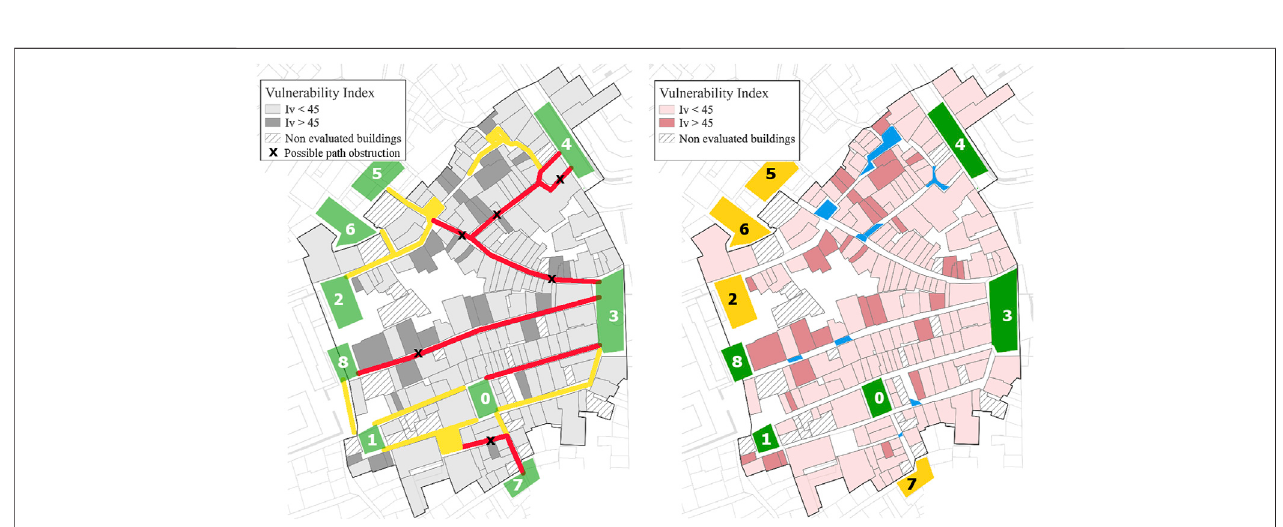
FIGURE6| Identi fi cationofgatheringareas(ingreenandyellow,includingidenti fi cation code0 – 8)andofthestreets with > 50%(red) and < 50%(yellow)ofthearea occupiedbydebris.Streetsblockagepositionsinducedbydebrisarealsoidenti fi edwithan “ X ” ,and “ spontaneous ” gatheringareasareidenti fi edinblue(Bernardiniand Ferreira, 2021). Maps like these facilitate the identi fi cation of critical failures on urban functions in post-event scenarios, providing valuable information for emergency planning and response decisions.